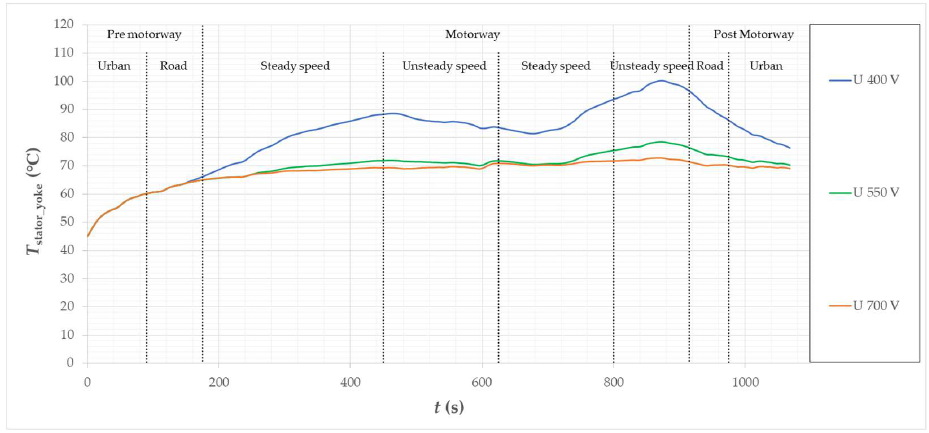
Figure 37. Calculated temperature waveforms in the motor stator yoke (hot spot) for the considered vehicle in the Artemis Motorway150 driving cycle .